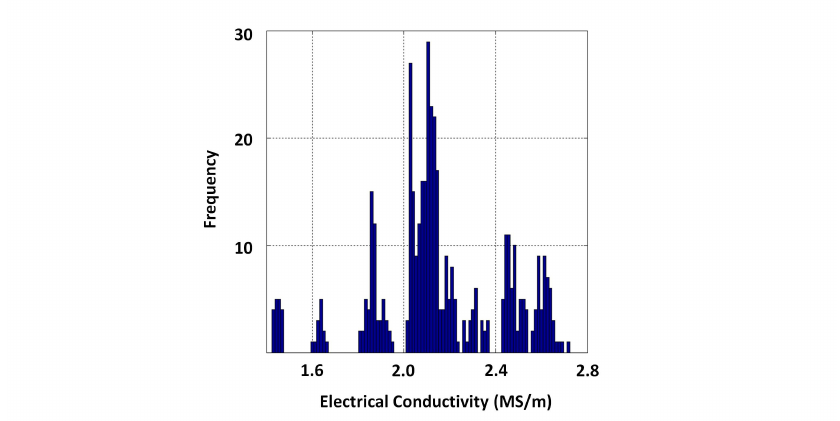
Figure 3. Histogram of the electrical conductivity of grey cast iron for temperatures between 283 K and 313 K captured.